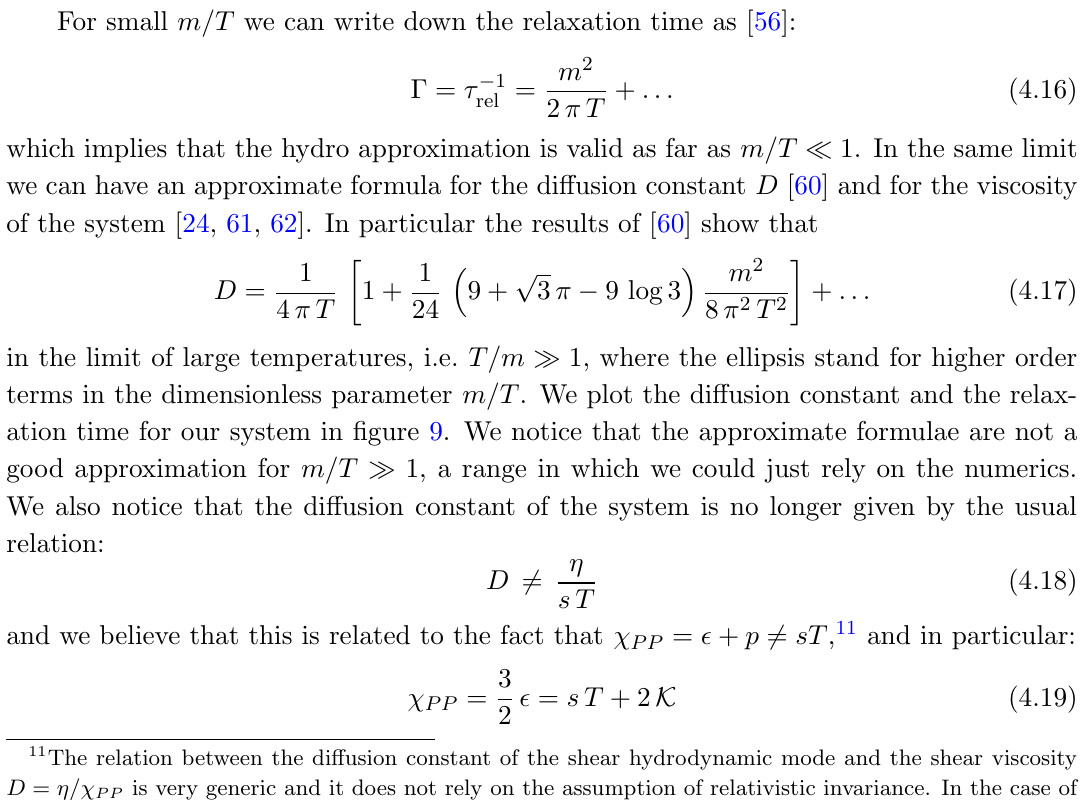
Figure 9 . Left: the relaxation time (cid:0) = (cid:28) (cid:0) 1 in function of temperature. The dots are the numerical rel values extracted from the QNMs while the purple curve is the approximated formula (4.16) valid for T=m (cid:29) 1. A similar plot can be found in [56, 57]. Right: the momentum di(cid:11)usion constant D extracted from the shear QNMs. The green curve is the approximated formula given in (4.17). The dashed line is the relativistic expression DT = 1 = 4 (cid:25) which turns out to be correct only at large temperature far from the regime drawn in this